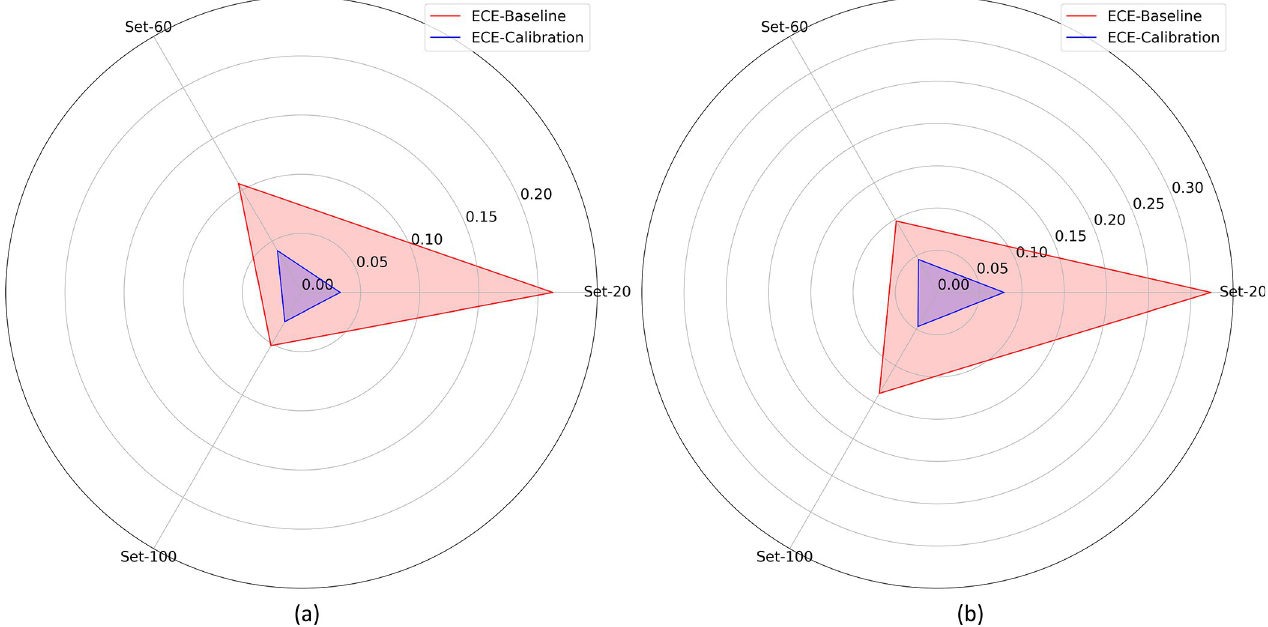
Fig 3. Polar coordinates plot showing the ECE metric achieved by the DenseNet-121 and VGG-16 models retrained on the Set-20, Set-60, and Set-100 datasets from (a) APTOS’19 fundus and (b) Shenzhen TB CXR datasets.